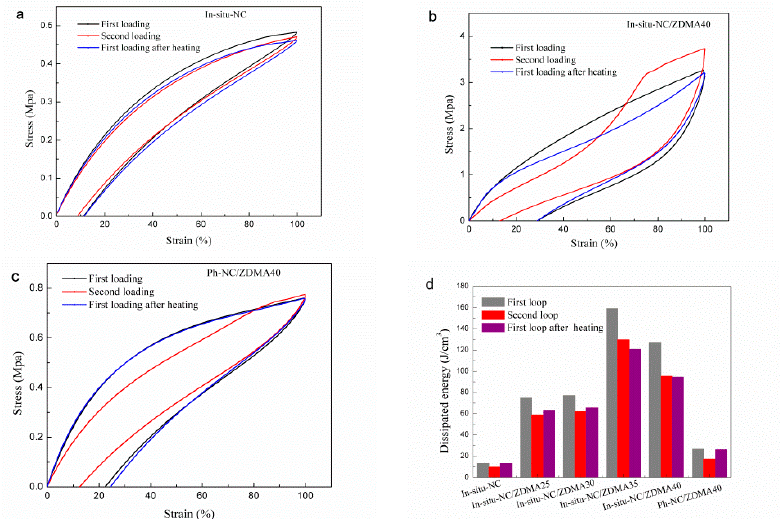
Figure 12. Cyclic tensile curves of ( a ) in-situ-NC, ( b ) in-situ-NC/ZDMA40 and ( c ) ph-NC/ZDMA40 and ( d ) the corresponding dissipation of energy.